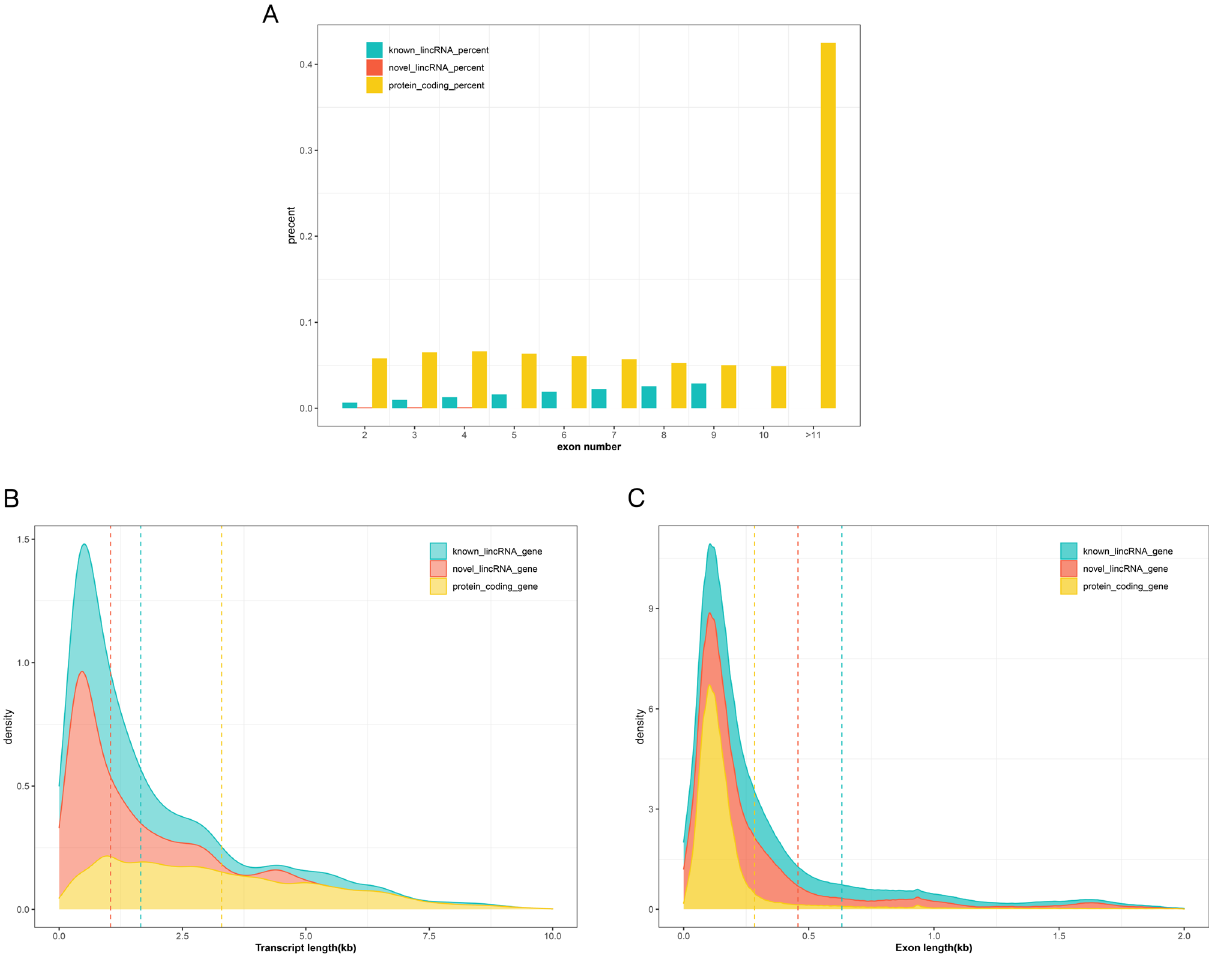
Figure 2. Characterization of identified lincRNAs. Characterization of identified lincRNAs. ( A ) The number of exons of different lincRNAs and protein-coding genes. ( B ) Probability density graph of the transcription length of different lincRNA and protein coding genes. ( C ) Probability density graph of the exon length of different lincRNAs and protein-encoding